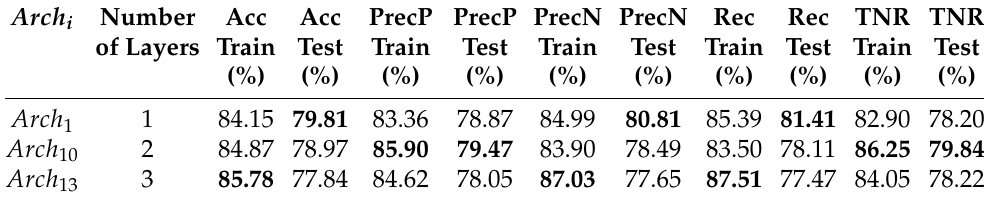
Table 7. Results for varying the number of layers.